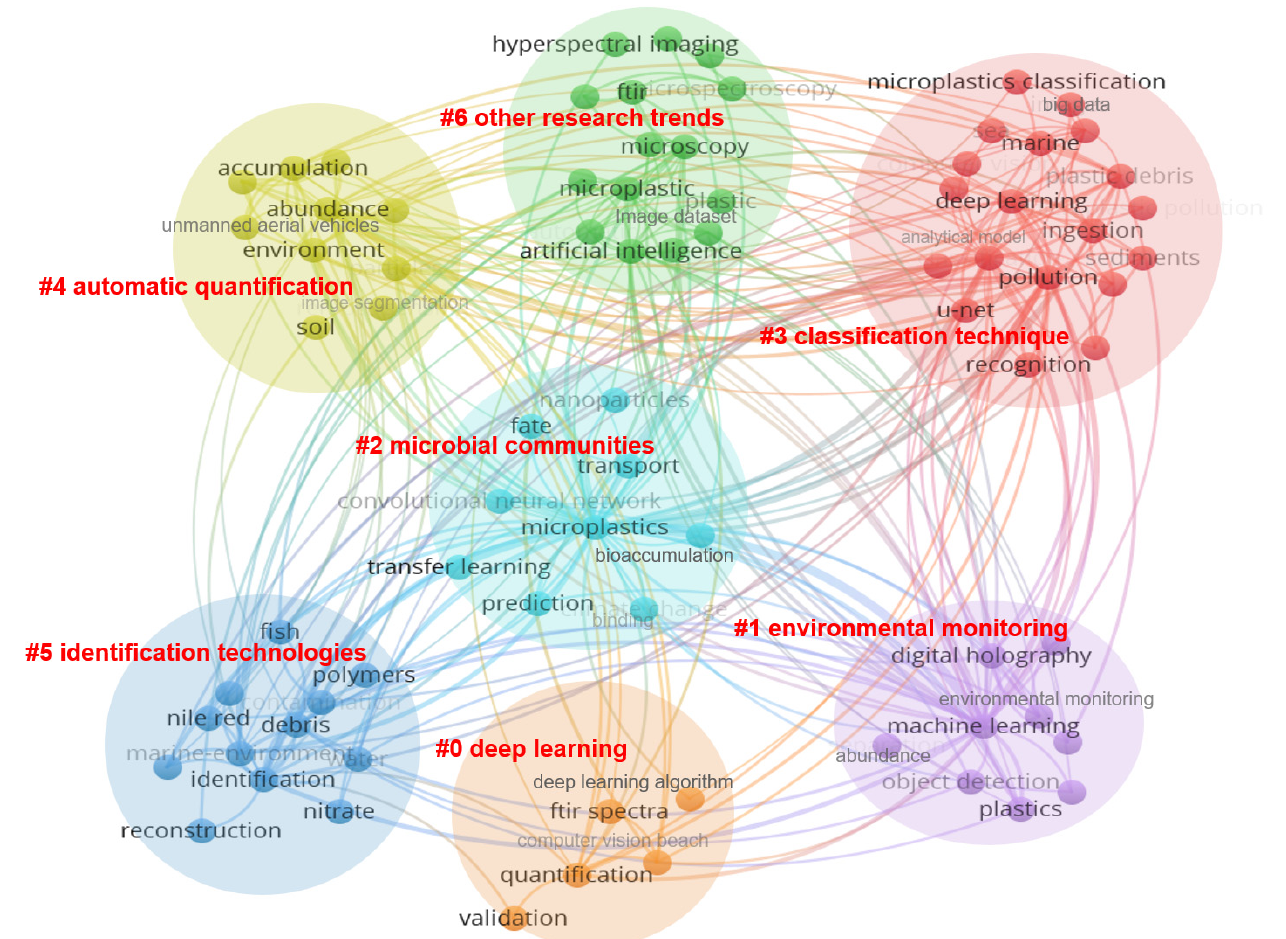
Figure 25. Research hot-spots from cluster view (generated using CiteSpace on data).